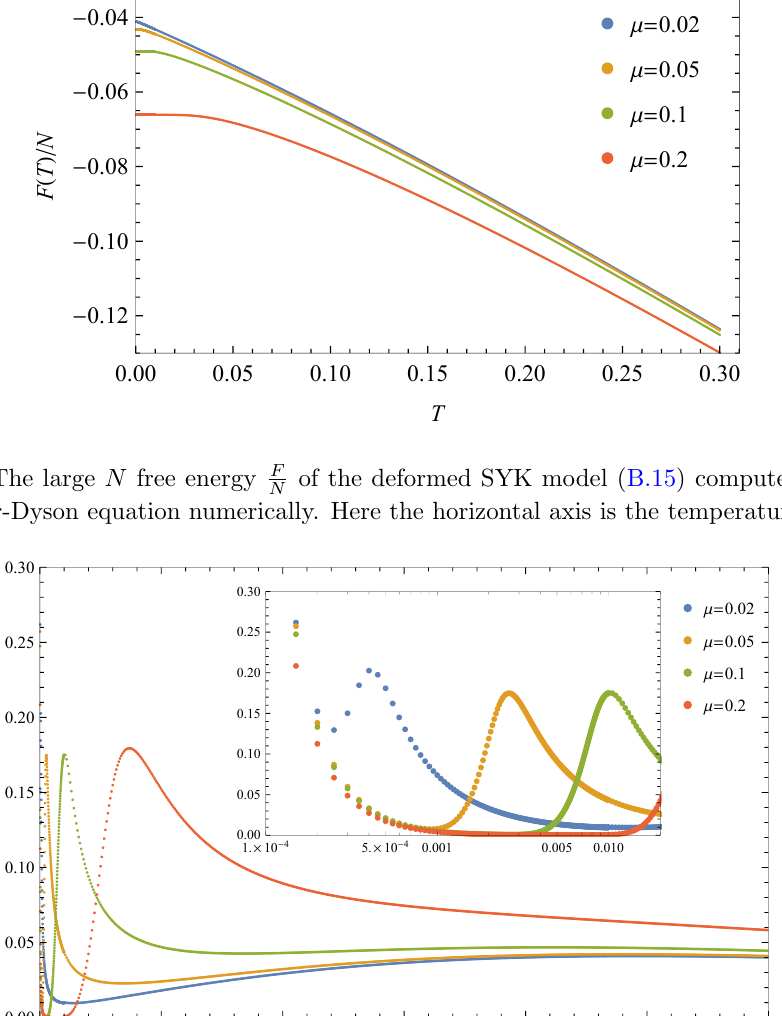
(3.45) of the deformed SYK model (2.1), here the N 0 is a (cid:25) ! n < 2 (cid:25) (cid:3) is not large (cid:12) j j